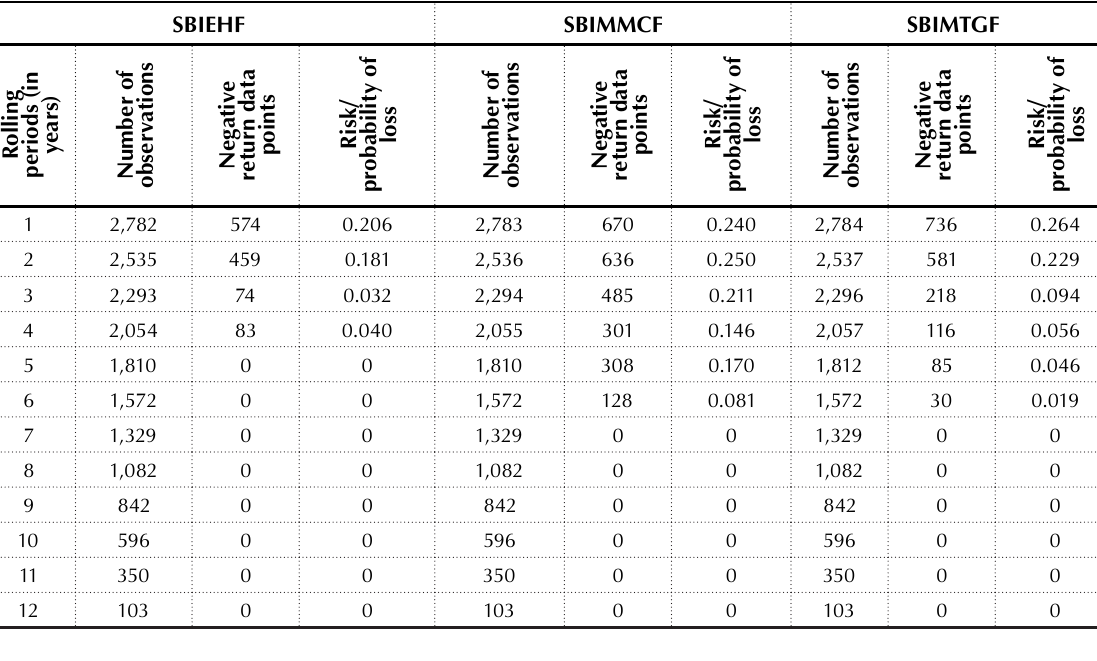
Table 20. Rolling period risk and return behavior of DSPEOF and SBIMMULCF (2006–2018) Rolling periods (in